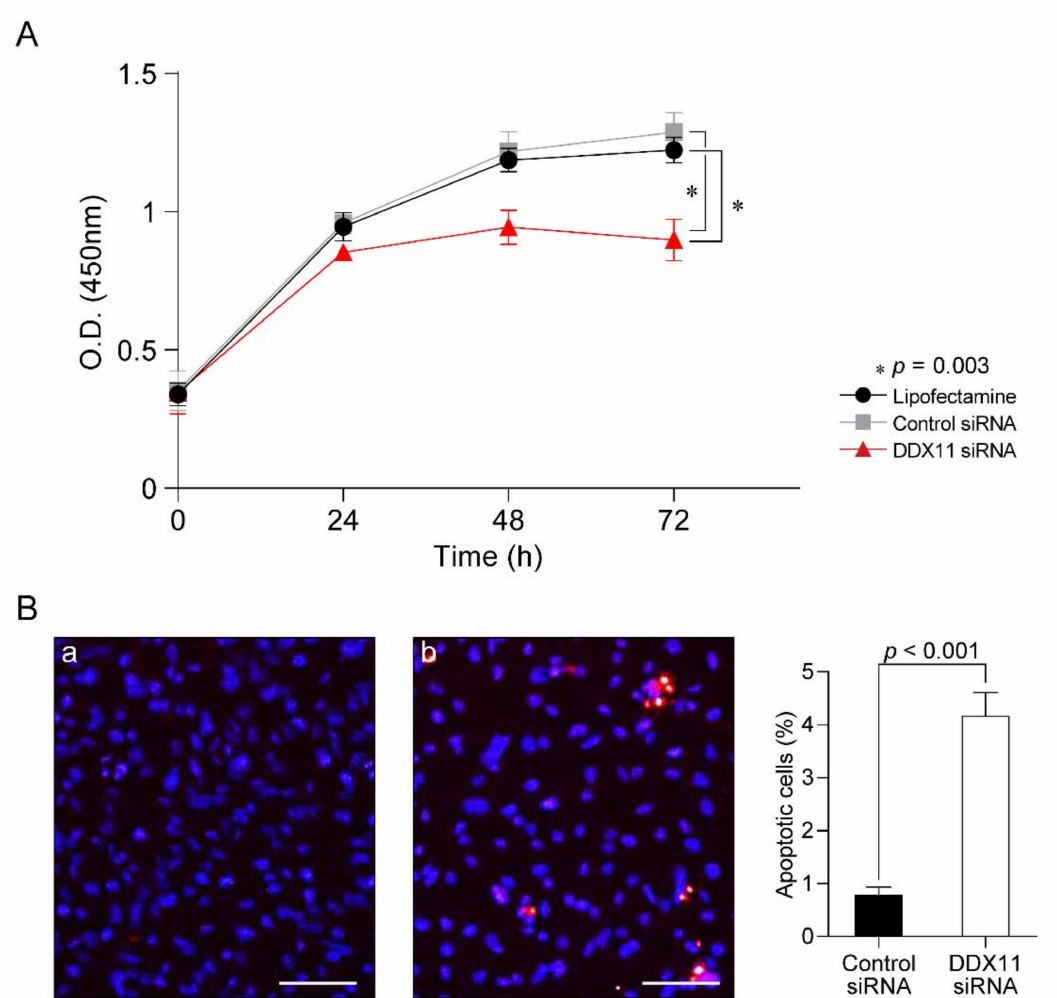
Figure 4. DDX11 knockdown in renal cell carcinoma cells resulted in the inhibition of proliferation and apoptosis. ( A ) Prolif- eration of 786-O cells that received only Lipofectamine (black-colored line) or were transfected with 25 nM of control siRNAs (gray-colored line) or 25 nM of DDX11 siRNA (red-colored line). The value at each time point following siRNA transfection is the mean of triplicate samples analyzed (* denotes p value with 0.003). ( B ) Apoptosis of 786-O cells transfected for 48 h with 50 nM of control siRNAs ( a ) or 50 nM of DDX11 siRNA ( b ) was analyzed using the TUNEL assay; TUNEL-positive cells (pseudocolored red), nuclei (pseudocolored blue), scale bar: 100 µ m.